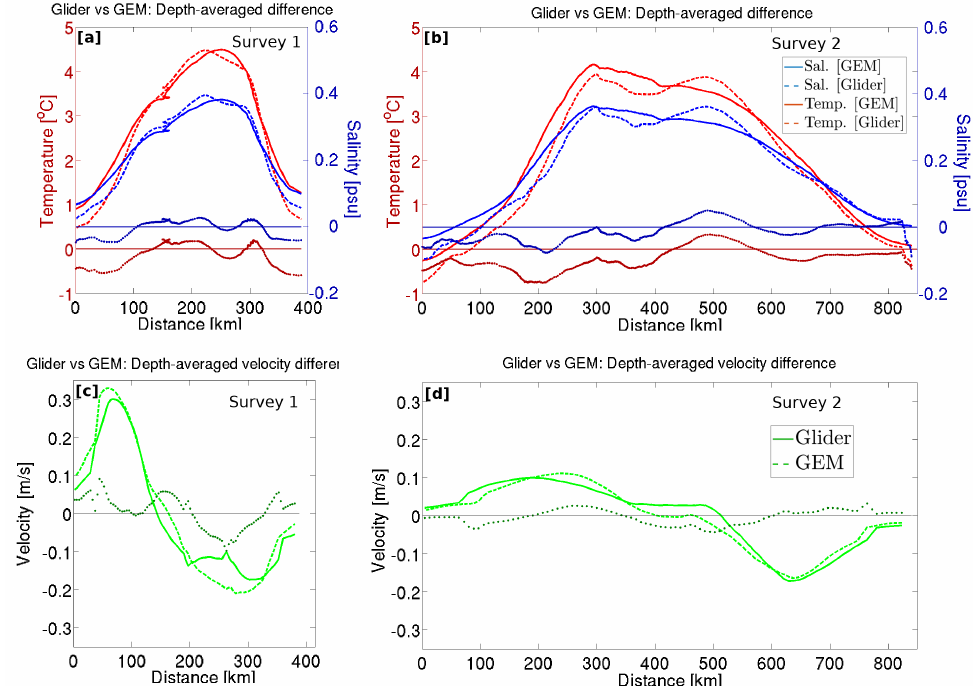
Figure 7. ( a , b ): Horizontalprofiles of depth-averaged temperature (red) and salinity (blue) anomalies. The glider observations are plotted as dotted lines, while the GEM-reconstructed profile is plotted as plain lines. The difference between the glider and GEM sections are plotted as dotted lines. ( c , d ): Same as ( a , b ) for the geostrophic